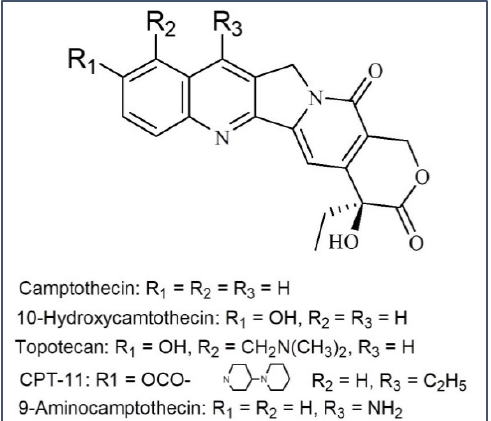
Figure 4. Analogs of